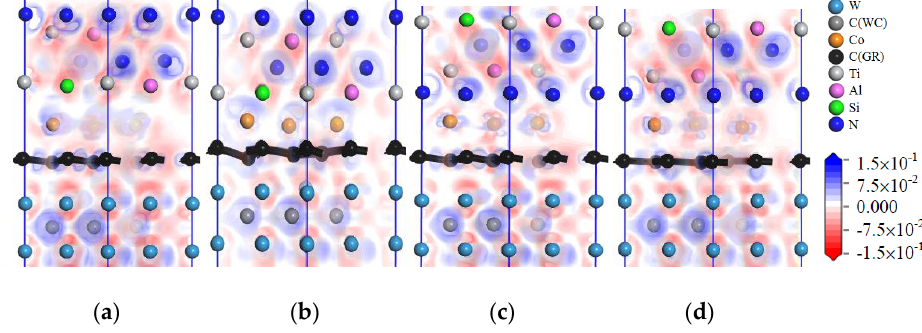
Figure 10. Charge-density difference image of the interface models with defective graphene doping in the matrix: ( a ) TiAlSiN Si /WC/svGR/Co; ( b ) TiAlSiN Si /WC/tdGR/Co; ( c ) TiAlSiN N /WC/svGR/Co; ( d ) TiAlSiN N /WC/tdGR/Co.